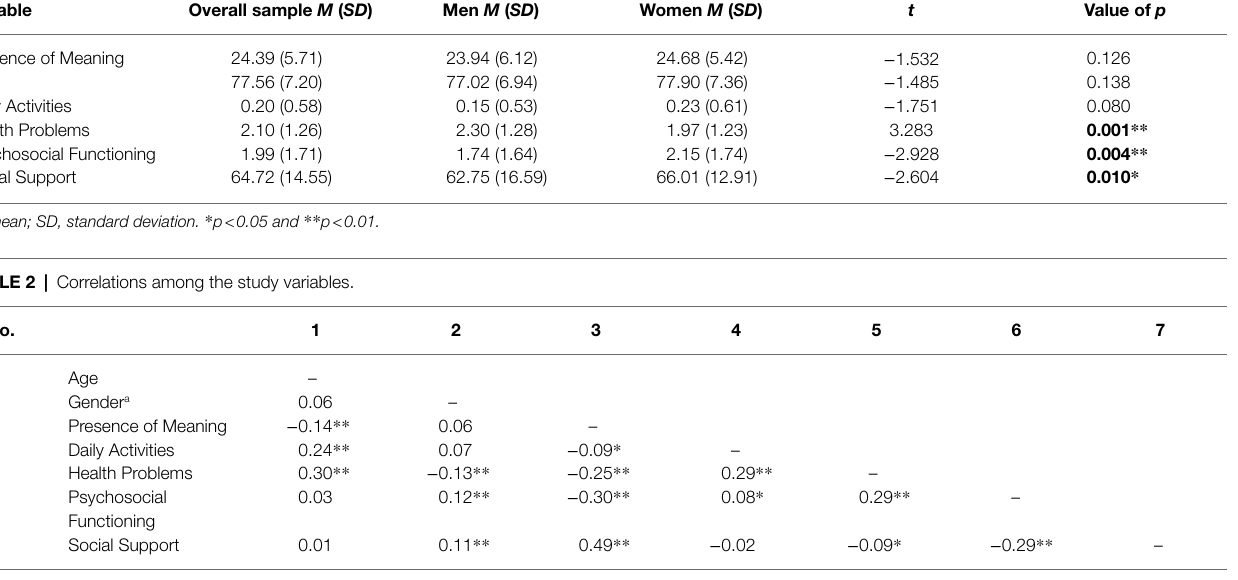
TABLE 1 | Descriptive statistics and t -test results for gender differences for the study variables. Variable